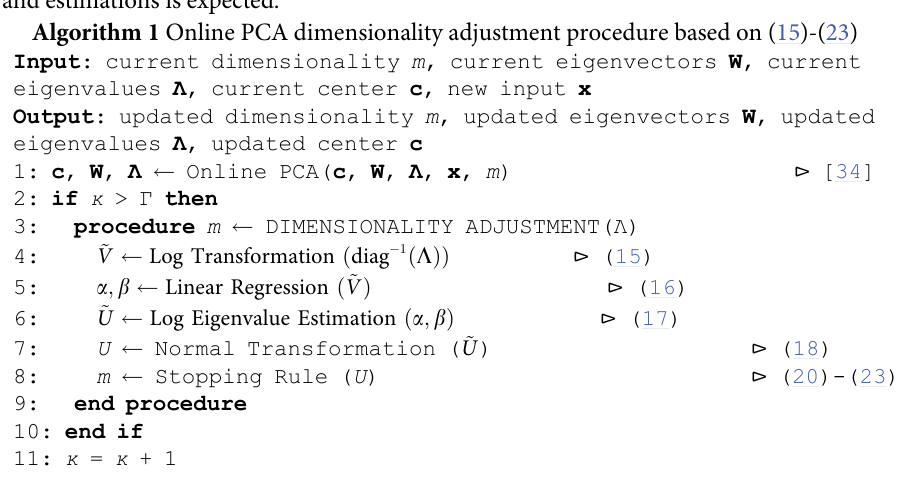
Algorithm 1 Online PCA dimensionality adjustment procedure based on